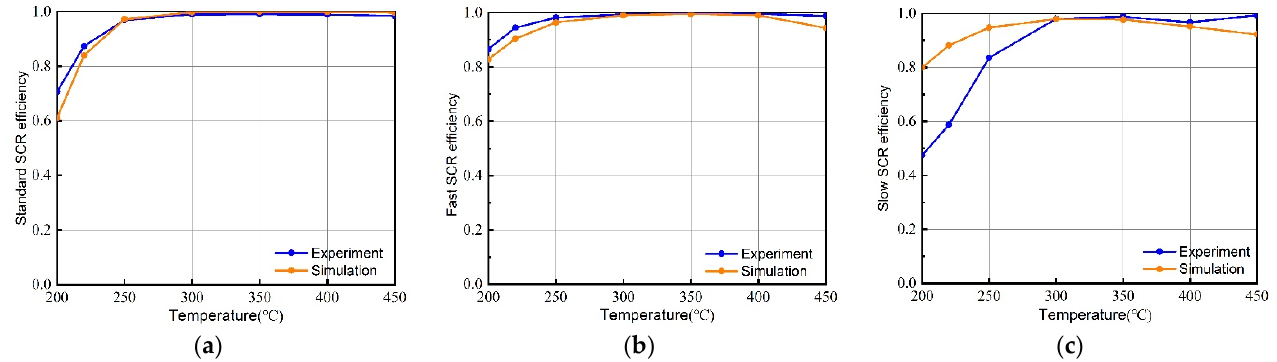
Figure 7. Comparison of NOx conversion efficiency experiment and simulation results. ( a ) Com- parison of standard SCR efficiency between experiment and simulation. ( b ) Comparison of fast SCR efficiency between experiment and simulation. ( c ) Comparison of slow SCR efficiency between experiment and simulation.